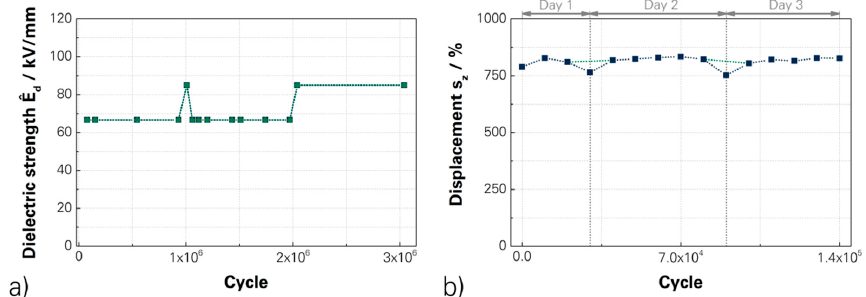
Figure 11. Investigated durability of the fully polymer DEAs for a ( a ) mechanical stress and cyclic measurement [15]; and ( b ) electro-mechanical stress under actuation conditions [15]—Table S1: actuators 10 and 11.